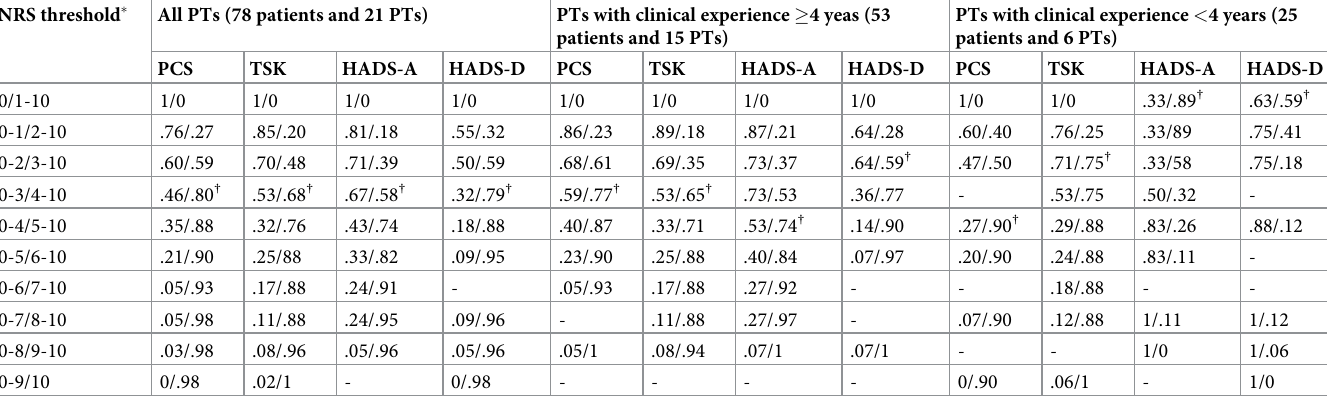
Table 3. Sensitivity and specificity of physical therapist (PT) estimates for psychological features through physical therapy evaluation considering the binary patient-reported outcome measure scores in all PTs and in the two PT subgroups according to clinical experience. NRS threshold � All PTs (78 patients and 21 PTs)